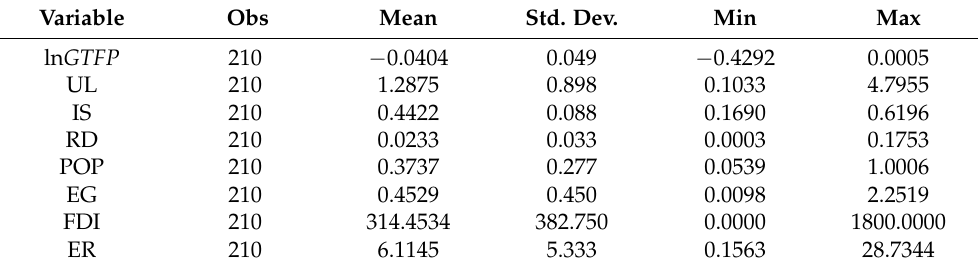
Table A1. Descriptive Statistics of Variables of the Northern China Sample.